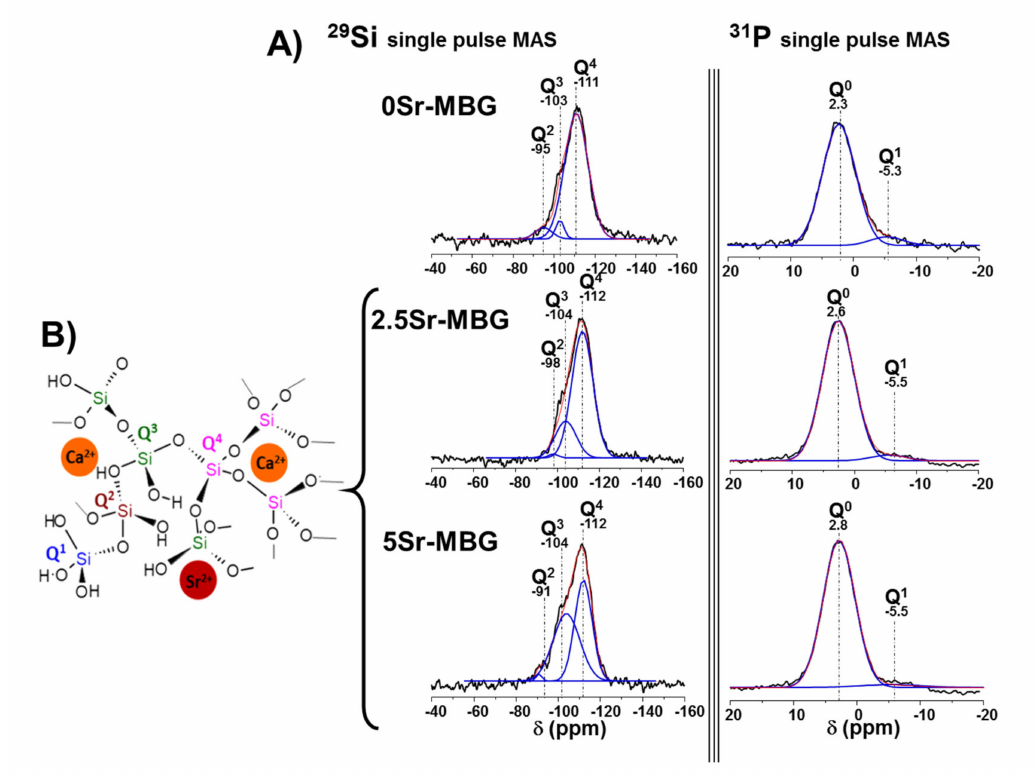
Figure 3. ( A ) Solid-state 29 Si and 31 P single-pulse magic angle spinning nuclear magnetic resonance (SP MAS-NMR) spectra of MBG samples. Q n areas were calculated by Gaussian line–shape deconvolution and are displayed in green. ( B ) Graphical representation of the silica structure of 0, 2.5 and 5Sr-MBG. The error associated to the fitting was the di ff erence between the black and red lines.